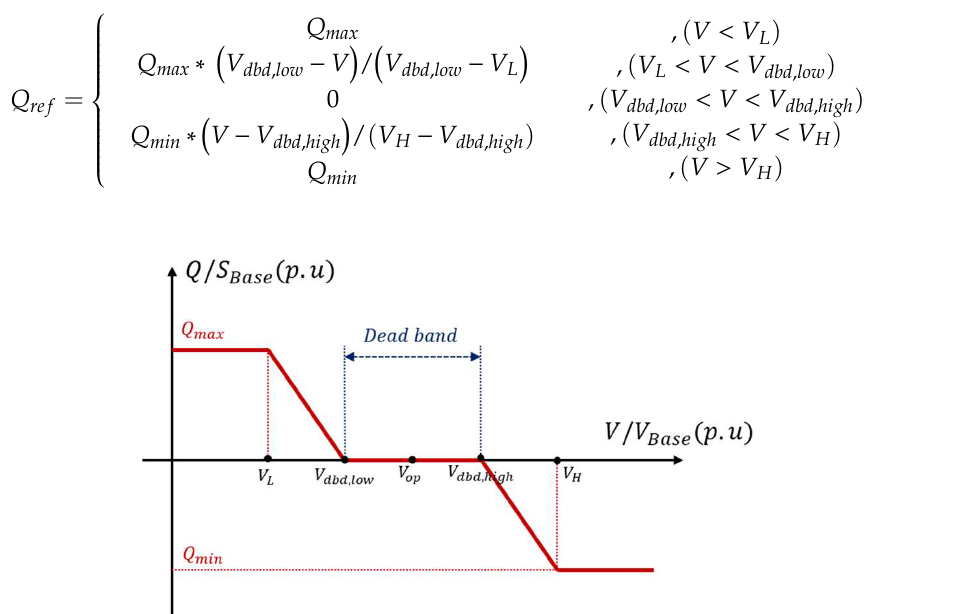
Figure 1. Characteristic curve of existing reactive power-voltage droop control method.